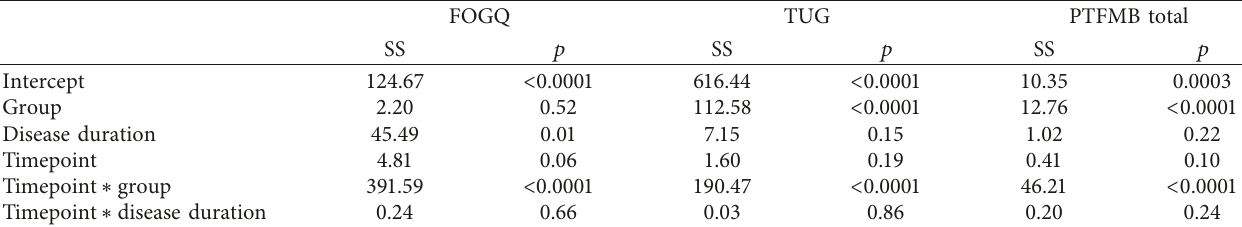
Table 3: Factors affecting FOGQ, TUG results, and the PTFMB total score before and after NW training. FOGQ TUG